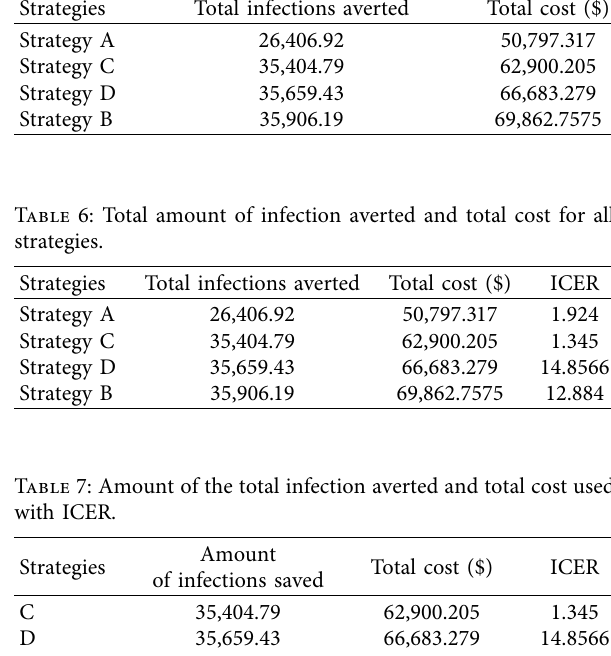
Table 5: Total amount of infection averted and total cost for all strategies. Strategies